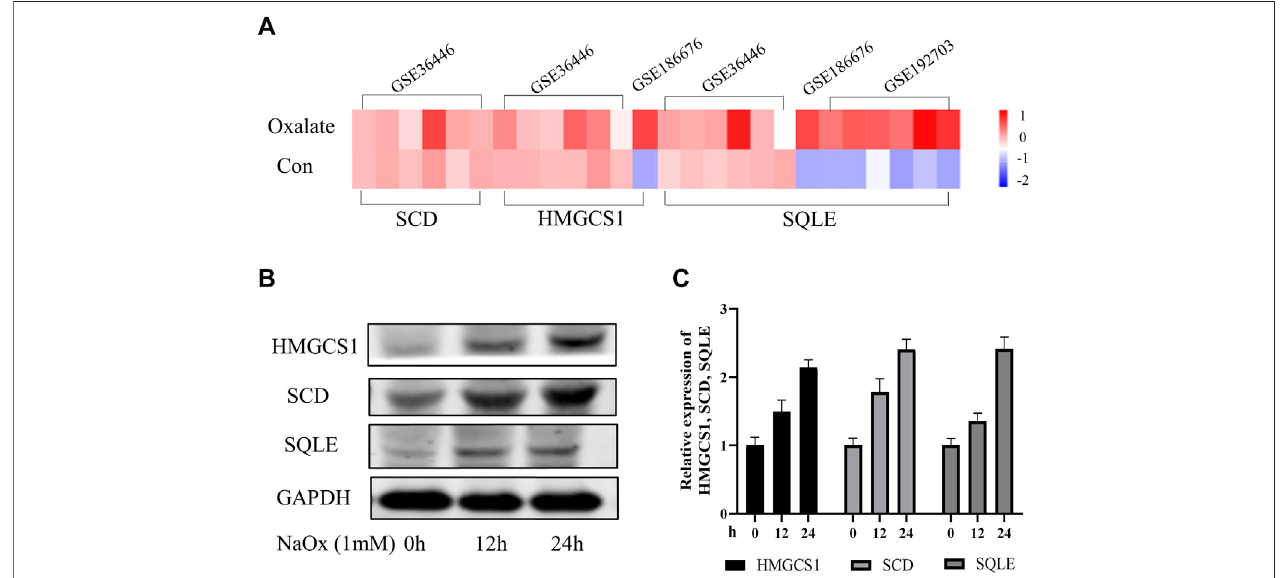
FIGURE3| ThechangingtrendofSQLE,HMGCS1, andSCDinoxalate-inducedrenalinjurymodels (A) TheHeatmapofSQLE,HMGCS1andSCDwereshownin three GSE databases (B) Expression of SQLE, HMGCS1 and SCD protein was detected by Western blot in the sodium oxalate group (NaOx) at 0, 12, and 24 h (C) Western blot displayed as column charts after quanti fi